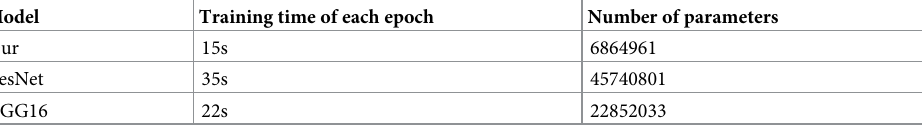
Table 15. The computational overhead and the number of parameters of each model.